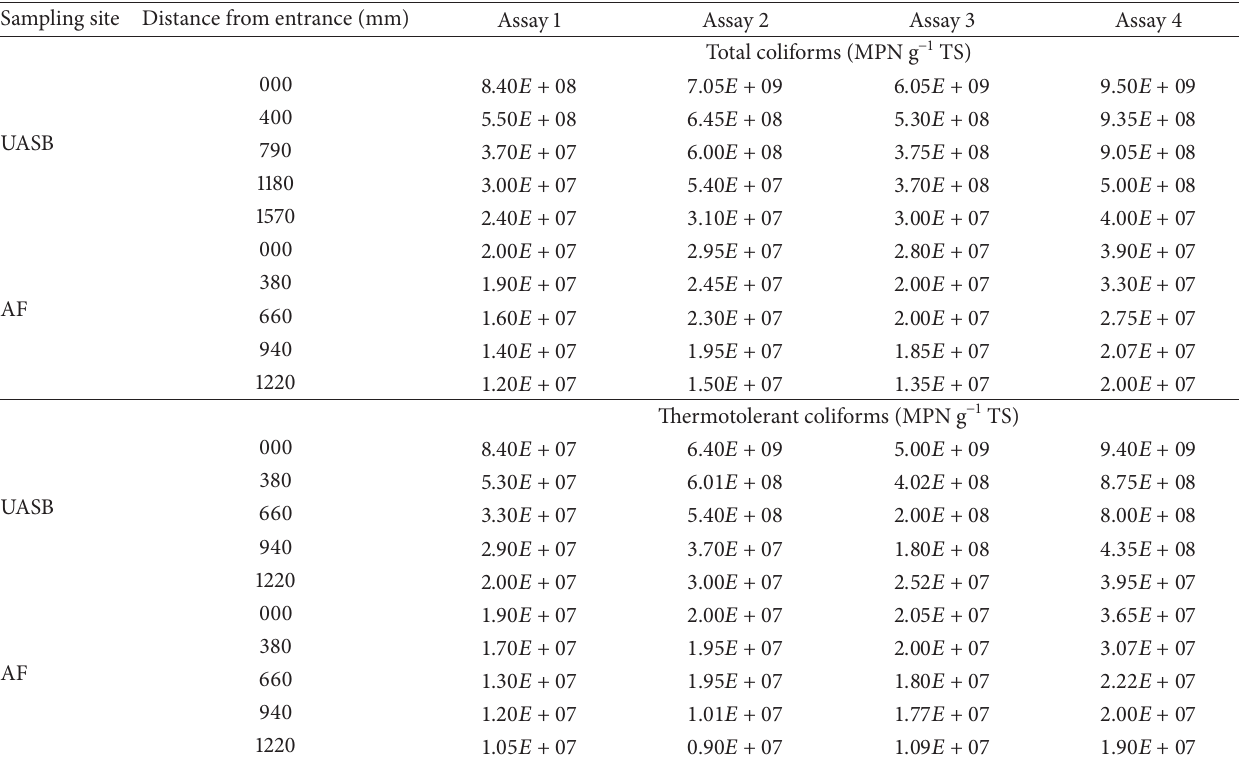
Table 5: Average of the most probable number (MPN/g − 1 TS) of total and thermotolerant coliforms in the sludge of the UASB reactor and upflow anaerobic filter (AF) placed in series, at pilot scale of the treatment system II, in assays 1, 2, 3 and 4. Sampling site Distance from entrance